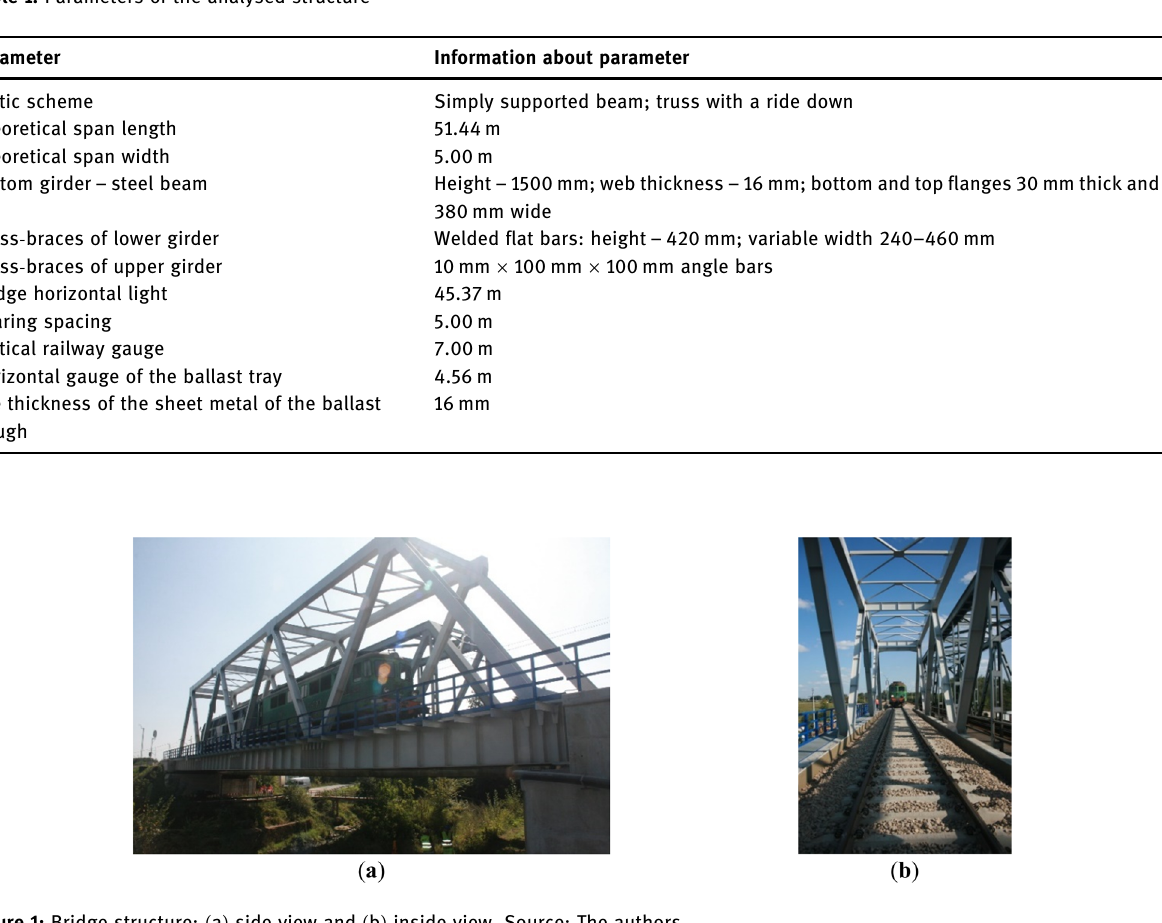
Table 1: Parameters of the analysed structure